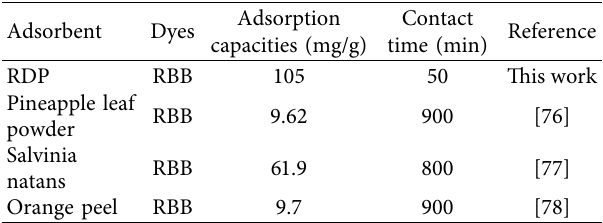
Table 6: Comparison of the treatment efficiency with literature